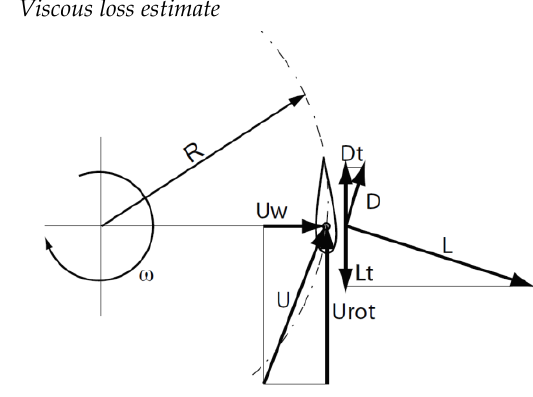
Fig. 3: Forces acting on a rotating hydrofoil of the CycWEC